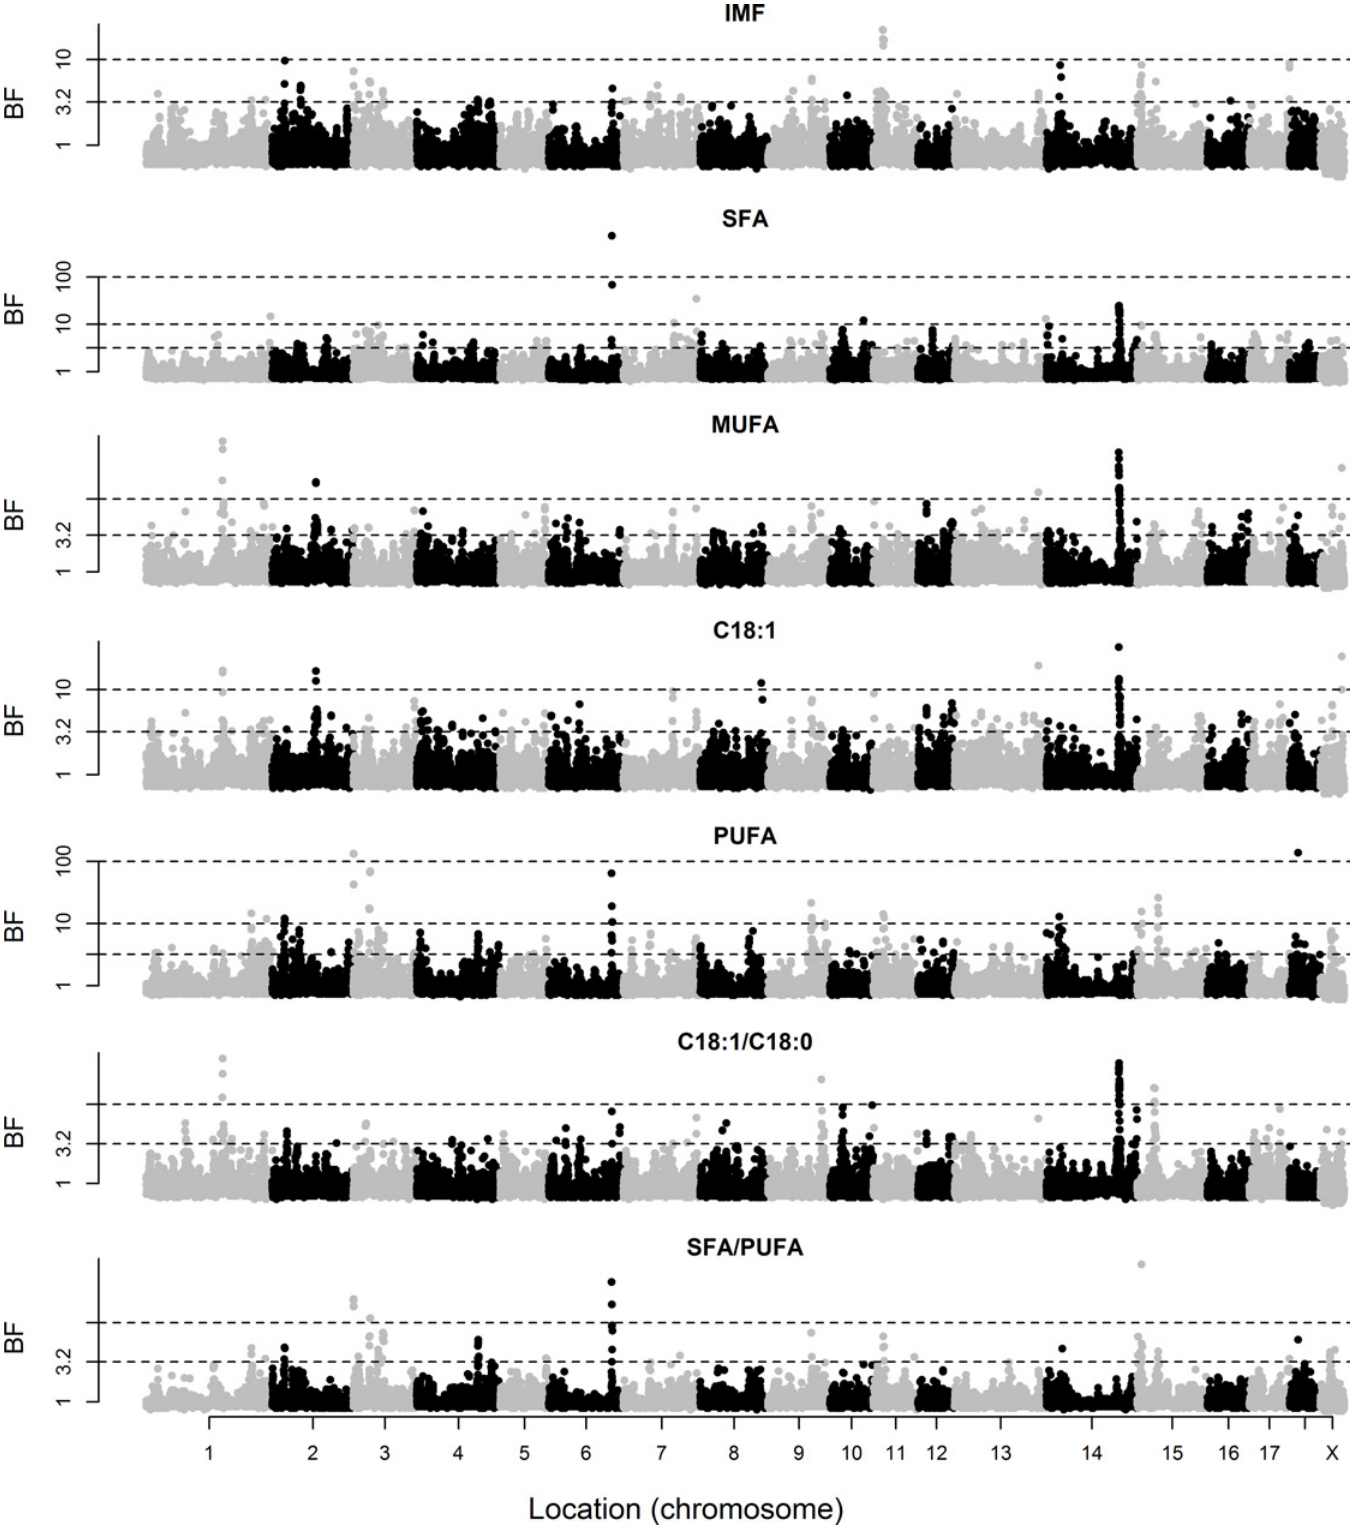
Fig 2. Bayes factors of individual markers for intramuscular fat (IMF) content and composition of longissimus dorsi . Fatty acid composition includes saturated (SFA), monounsaturated (MUFA), and polyunsaturated (PUFA) fatty acids, individual oleic acid (C18:1), and the ratios of oleic to stearic acid (C18:1/C18:0) and SFA/PUFA. The discontinuous lines indicate Bayes Factors of 3.2 (substantial evidence), 10 (strong), and 100 (decisive). doi:10.1371/journal.pone.0152496.g002 PLOS ONE | DOI:10.1371/journal.pone.0152496 March 29,